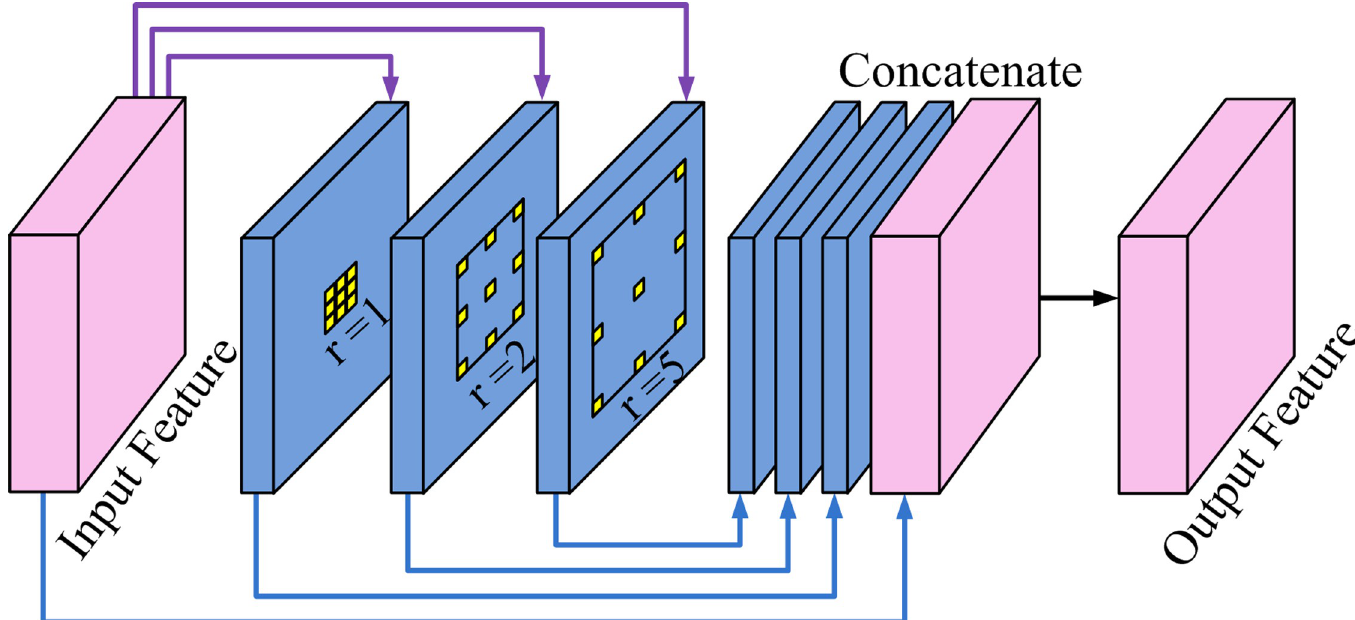
Fig 3. Structure of HDC module. The sizes of input feature maps are 128 × 128 × 128 and 64 × 64 × 256 successively. The dilation rates set to 1, 2, and 5, respectively.